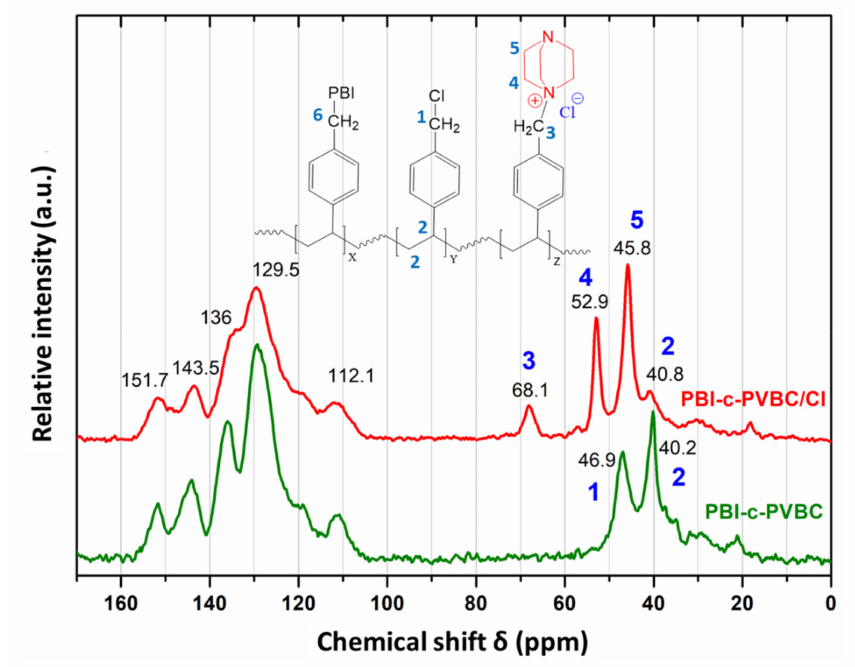
Figure 6. Solid 13 C-NMR spectra of PBI-c-PVBC and PBI-c-PVBC /